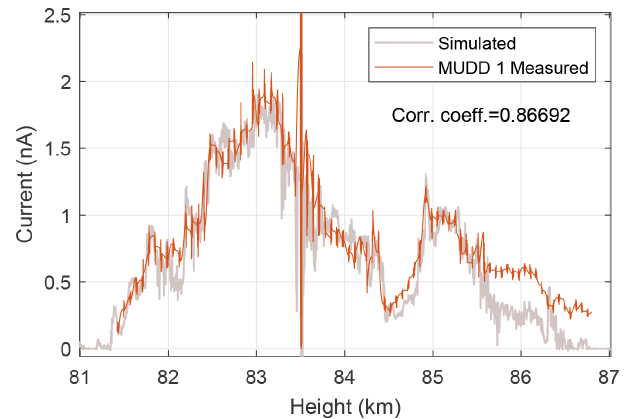
Figure 7. Measurements from the impact Faraday cup MUDD flown on the MXD-1 sounding rocket payload (red) and a best fit from simulation of contact charging (grey) using the fragmentation model described in Sect. 2.1. V c = 0 . 5eV was found to be the best fit for fragments of density ρ = 3000kgm − 3 and yield pressure 50MPa. The minimum fragment size threshold was set to